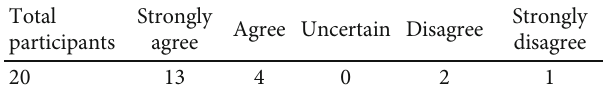
Table 5: Experiment result